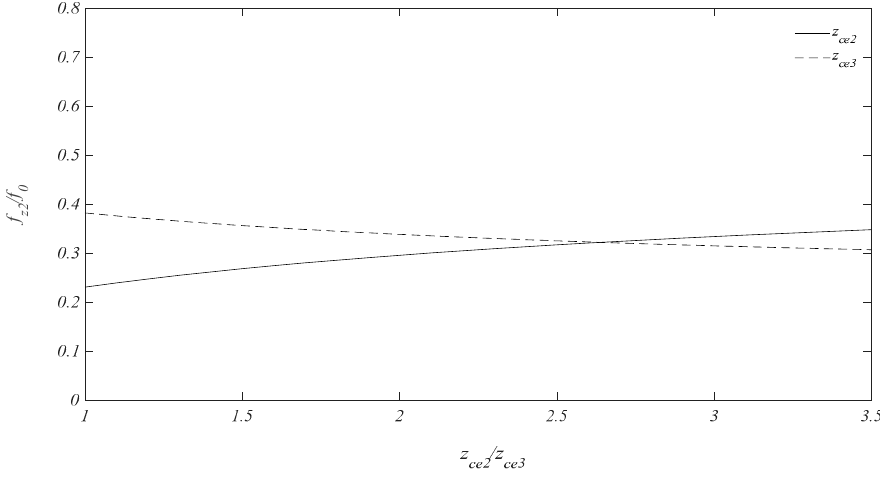
.The impedance moves to high